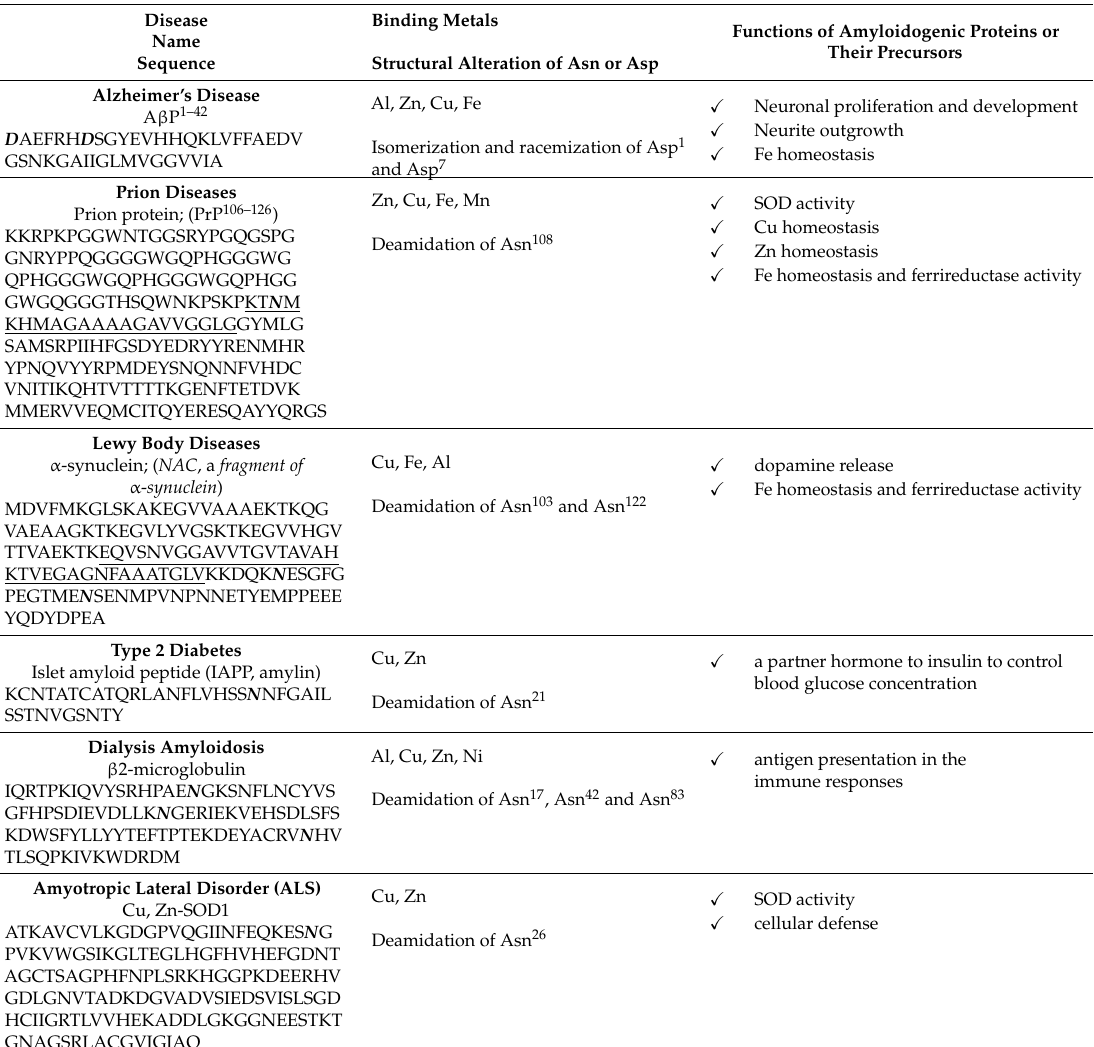
Table 1. Characteristics of amyloidogenic proteins and related